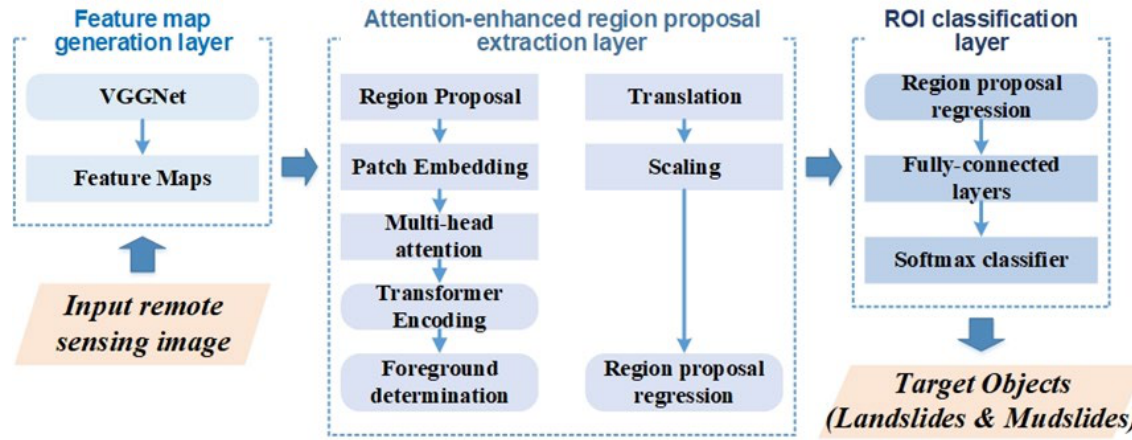
Figure 1. Architecture of the proposed approach.